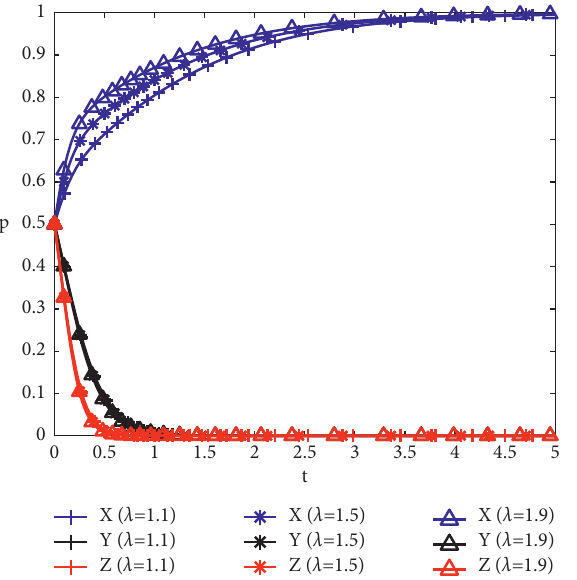
Figure 11: Evolution path under different costs of